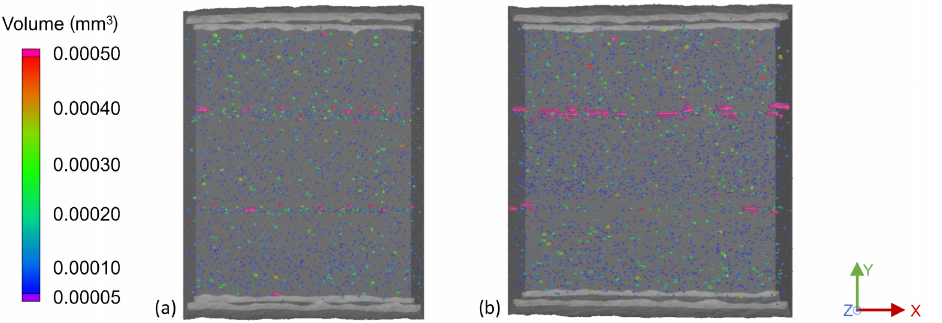
Figure 7. Top view of the porosity of two triple-strand specimens at a substrate temperature of 200 °C and a layer height of 1.0 mm with strand distances of ( a ) 2.5 mm and ( b ) 2.8 mm.